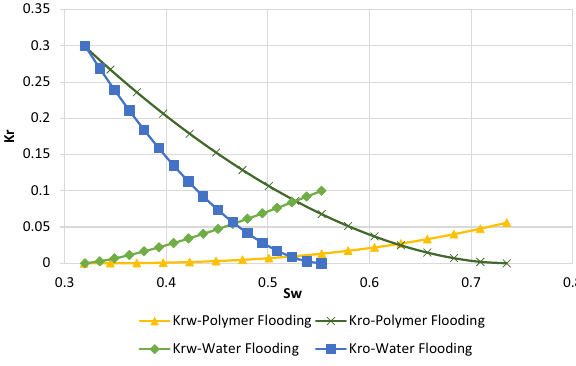
Fig. 16 Comparison of relative permeability curve for water and pol-